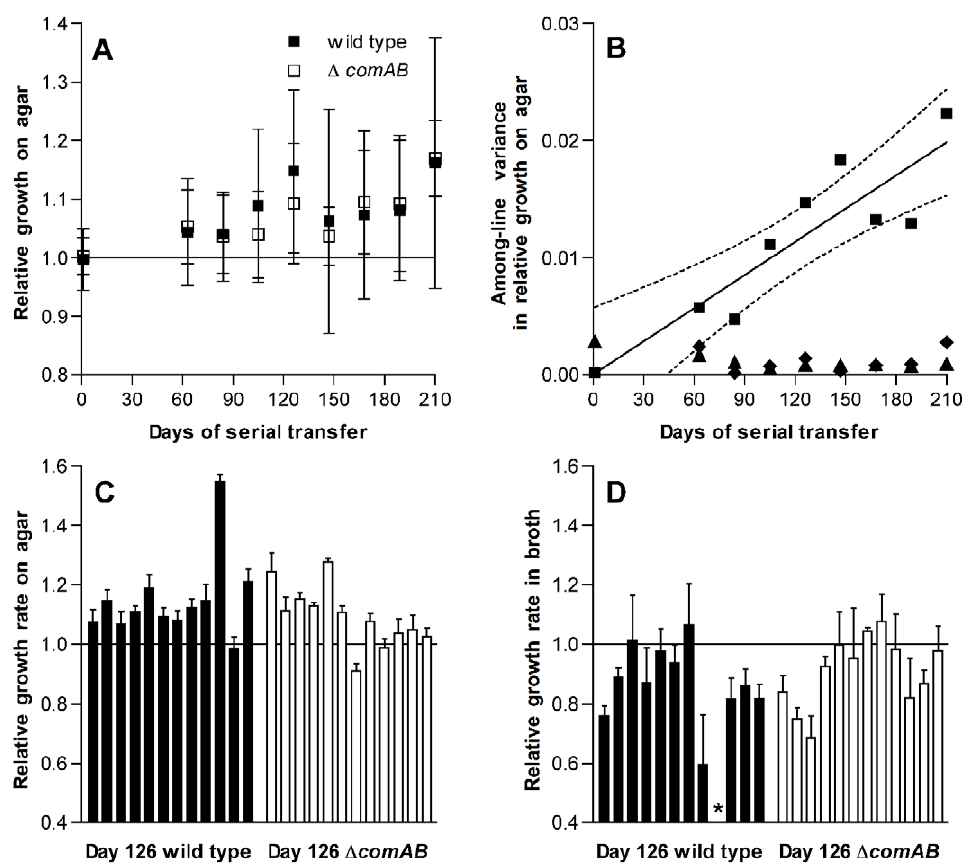
Figure 1. Changes in fitness of S.pneumoniae over single-colony serial transfer. (A) Relative growth after 24 h of incubation on THY agar plates expressed as the ratio of log 2 (CFU/colony) for passaged isolates based on 3 replicate measurements for each isolate compared to day 1 control isolates. Symbols represent average fitness values for independently passaged lines 6 S.D. The increase in fitness with duration of passage is significant ( F [8,185] =3.65, P =0.0006), but differences between D comAB and wild-type lines were not significant ( F [1,185] =0.18, P =0.67). (B) Variance components of fitness measurements based on relative log 2 (CFU/colony) for serial transfer lines. Among-line variances for passaged strains are shown with squares. Linear regression of the among-line variance against duration of passage is shown by a solid line, with dotted lines indicating 95% confidence intervals. Among-line variances for day 1 control isolates assayed in parallel at each stage of serial transfer are shown with diamonds. Triangles represent within-line variances for passaged strains. Data from wild-type and D comAB lines are pooled. (C) Relative growth on agar plates, as in panel A, for individual isolates after 126 days of serial transfer. The effect of lineage on fitness was significant ( F [23,71] =34.01, P , 0.0001). n=3 for each lineage. (D) Relative growth in THY broth, expressed as the ratio of maximum growth rates for passaged isolates compared to day 1 control isolates, after 126 days of serial transfer. The effect of lineage on fitness was significant ( F [22,68] =4.96, P , 0.0001). n=3. Bars represent mean values 6 S.D. The asterisk indicates an isolate that was unable to grow in broth culture.